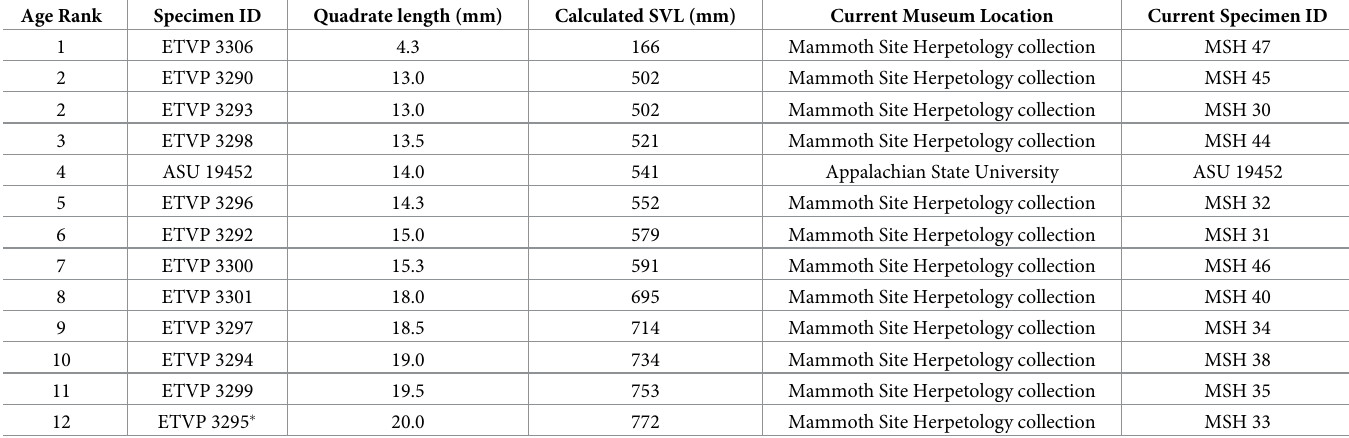
Table 1. Calculated SVL (mm) and Age Ranks (AR) using quadrate length